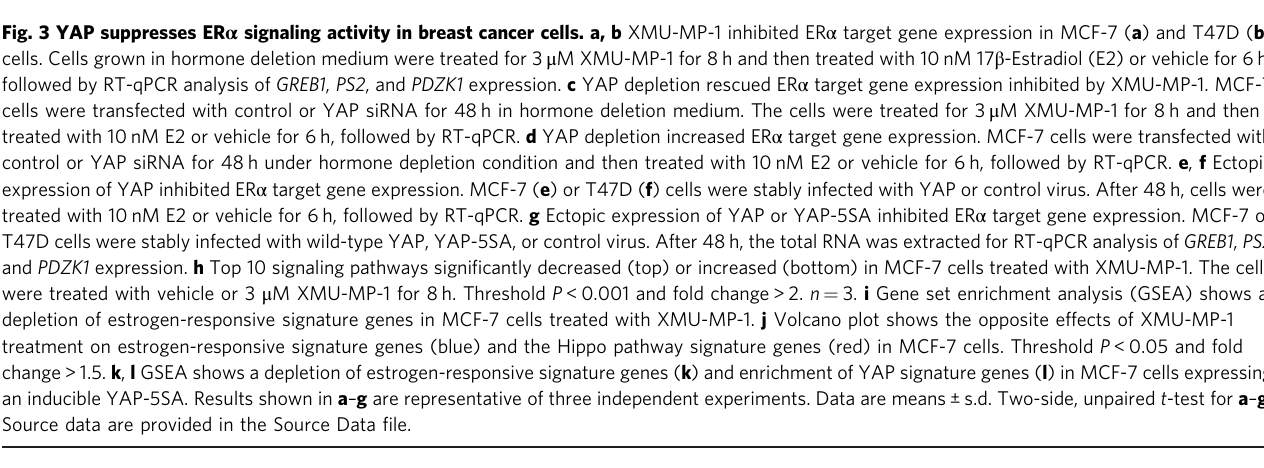
Fig. 3 YAP suppresses ER α signaling activity in breast cancer cells. a, b XMU-MP-1 inhibited ER α target gene expression in MCF-7 ( a ) and T47D ( b ) cells. Cells grown in hormone deletion medium were treated for 3 μ M XMU-MP-1 for 8 h and then treated with 10 nM 17 β -Estradiol (E2) or vehicle for 6 h, followed by RT-qPCR analysis of GREB1 , PS2 , and PDZK1 expression. c YAP depletion rescued ER α target gene expression inhibited by XMU-MP-1. MCF-7 cells were transfected with control or YAP siRNA for 48 h in hormone deletion medium. The cells were treated for 3 μ M XMU-MP-1 for 8 h and then treated with 10 nM E2 or vehicle for 6 h, followed by RT-qPCR. d YAP depletion increased ER α target gene expression. MCF-7 cells were transfected with control or YAP siRNA for 48 h under hormone depletion condition and then treated with 10 nM E2 or vehicle for 6 h, followed by RT-qPCR. e , f